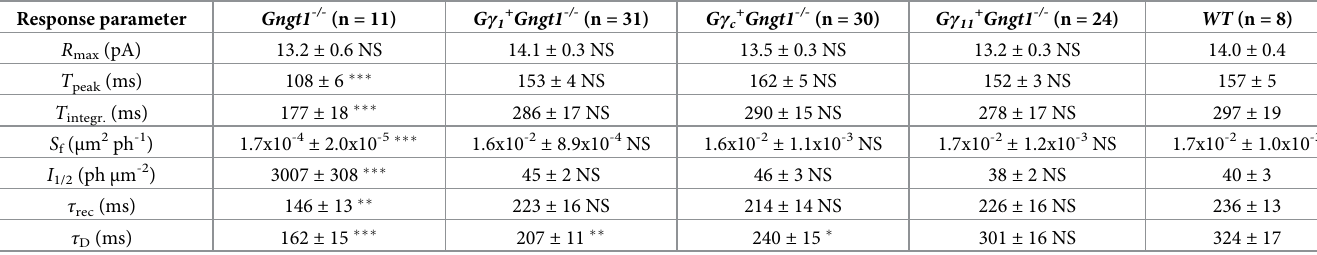
R max , maximal dark current measured from saturated responses; time-to-peak ( T peak ), integration time ( T integr. ), and normalized flash sensitivity ( S f ) refer to responses whose amplitudes were * 0.2 � R max and fell within the linear range; I 1/2 , half-saturating light intensity; τ rec , time constant of single-exponential decay of the dim flash response recovery phase; τ D , dominant time constant of recovery after supersaturating flashes determined from the linear fit to time in saturation vs. intensity semilog (Pepperberg) plots [23]. Data are presented as mean ± SEM. Student’s t-test, NS (not significant) indicates p > 0.05 � indicates p < 0.05 �� indicates p < 0.01 ��� indicates p < 0.001, all compared to wild type